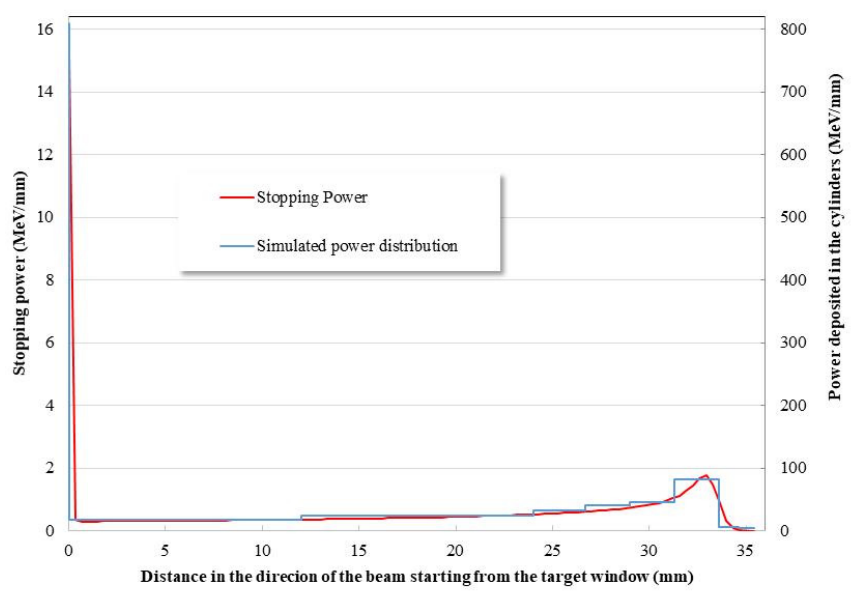
Figure 2. Stopping power of the proton beam along its trajectory (grey curve) and simulated matching power distribution used in the simulations (black curve).